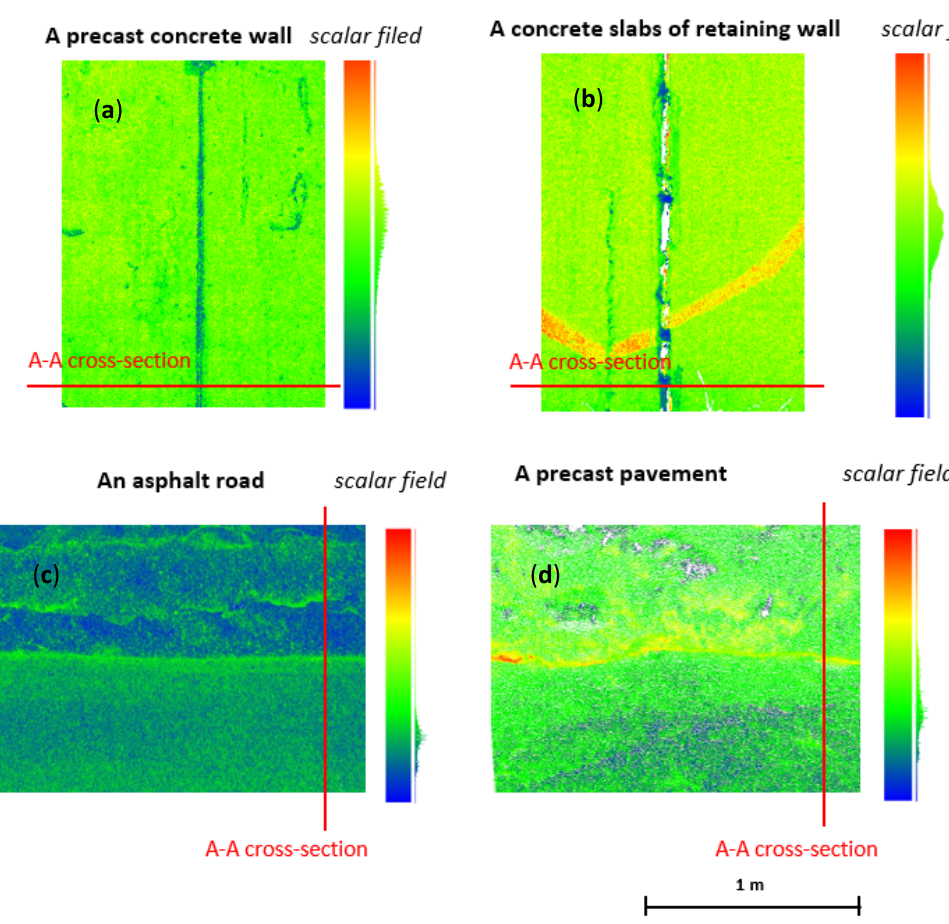
Figure 5. Point clouds representing the objects presented in Figure 2 ( a – d , respectively).